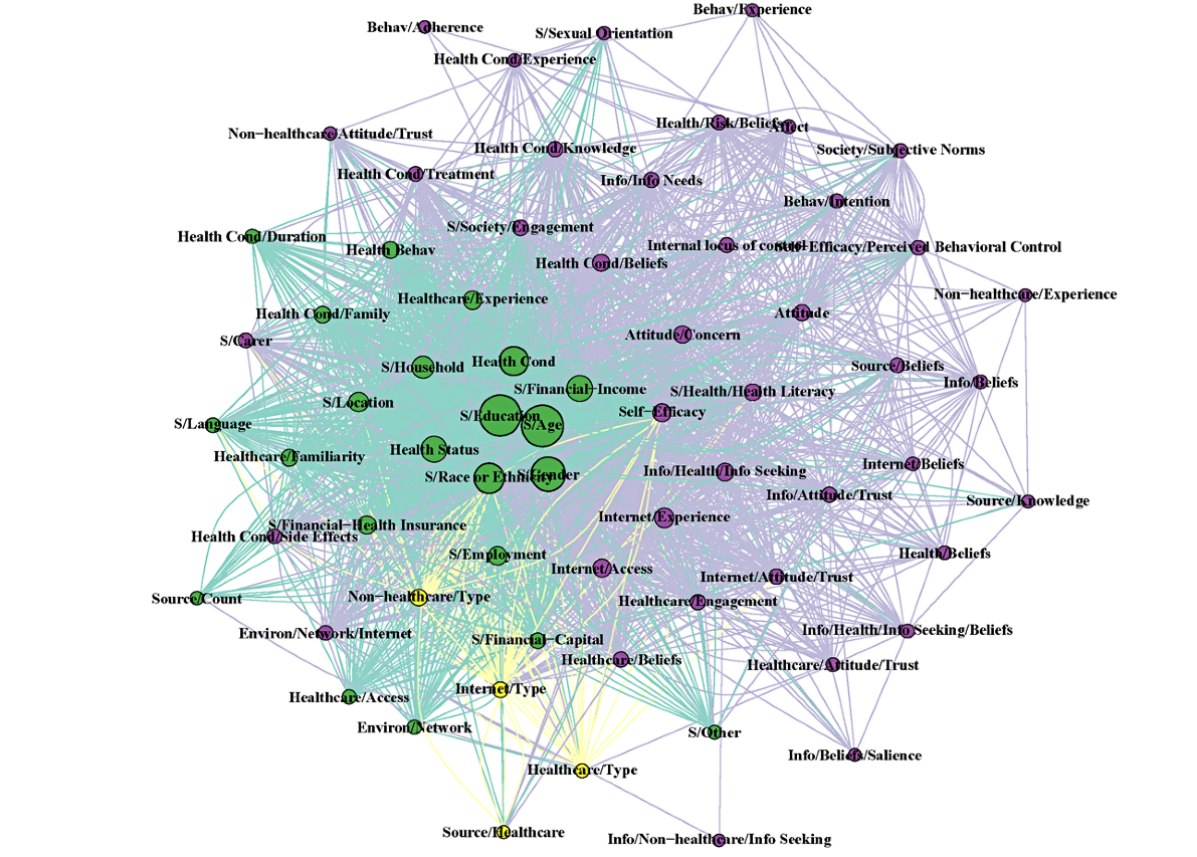
Figure 4. Fruchterman-Reingold layout algorithm of the network analysis comparing the post-2008 network model with color coding according to the modularity group membership of the complete model. The repository is available on GitHub